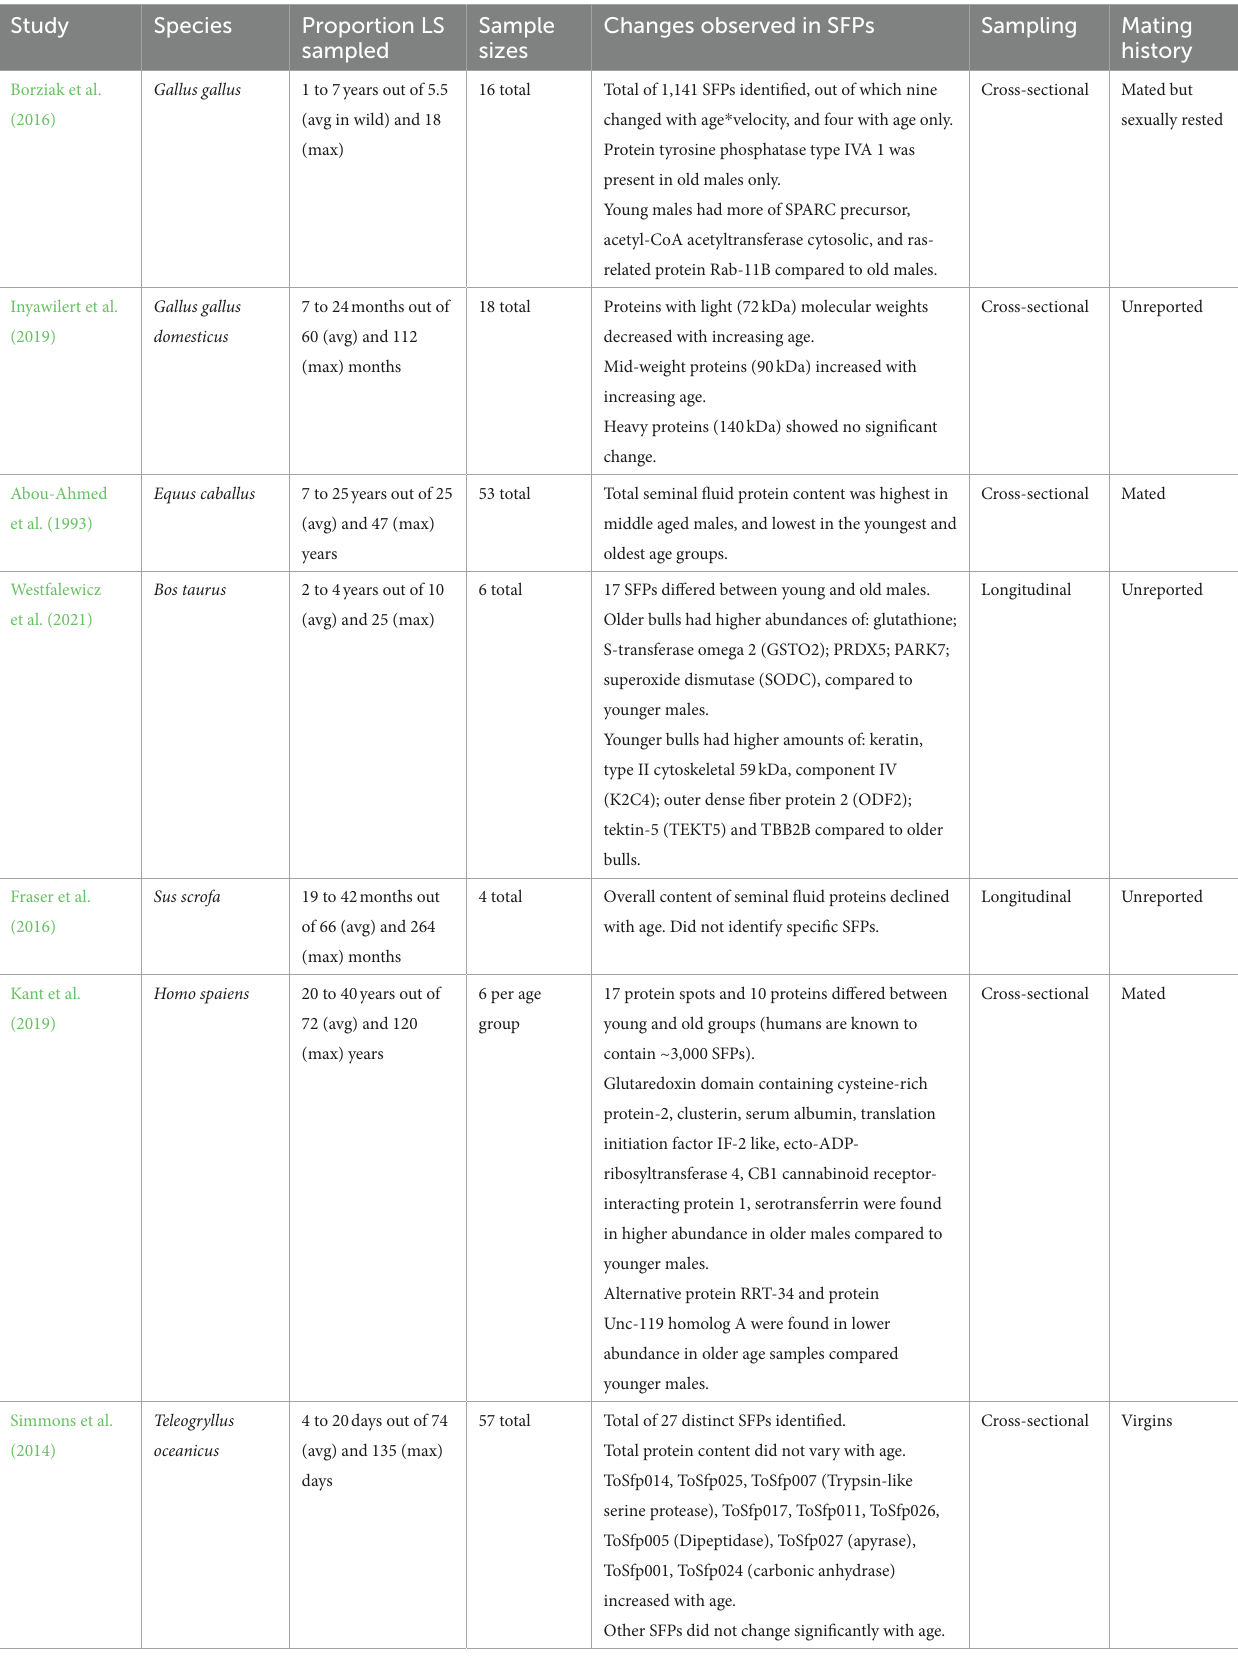
TABLE 1 Summary of studies testing the effect of male age on seminal fluid proteins across different taxa as found in the systematic